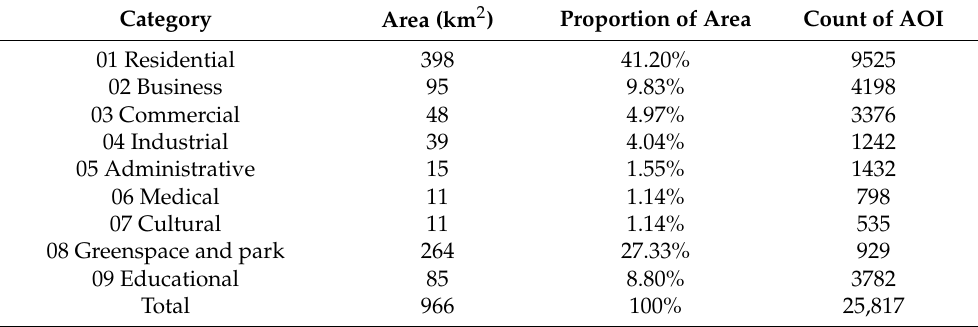
Table 2. Overview of the AOI